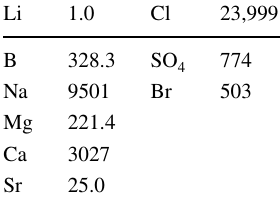
Table 2 Concentration of ions contained in the landfill leachate